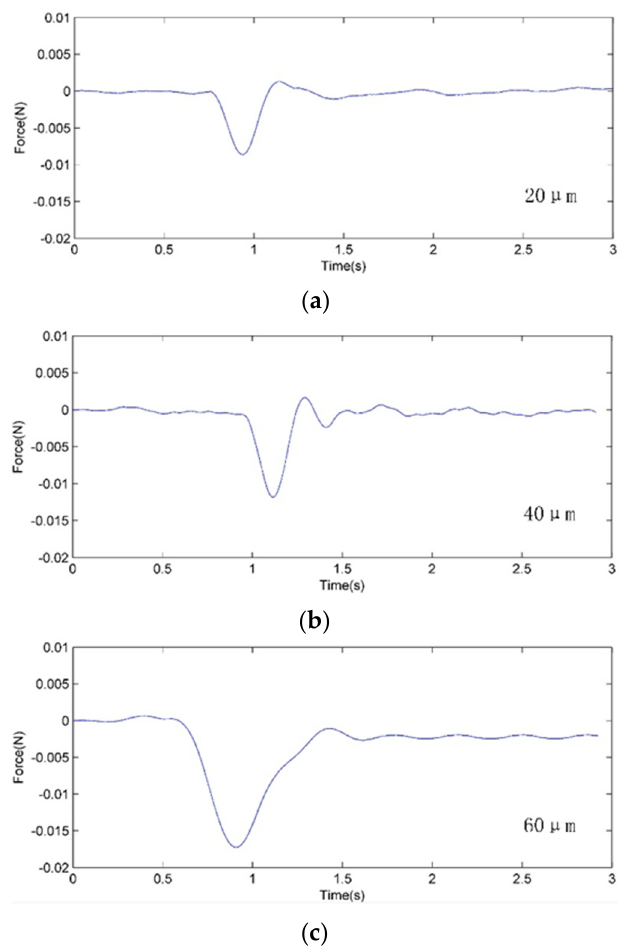
Figure 15. Injection force trajectories for different needle diameters. ( a ) Force curve of 20 µm diameter; ( b ) Force curve of 20 µm diameter; ( c ) Force curve of 20 µm diameter.